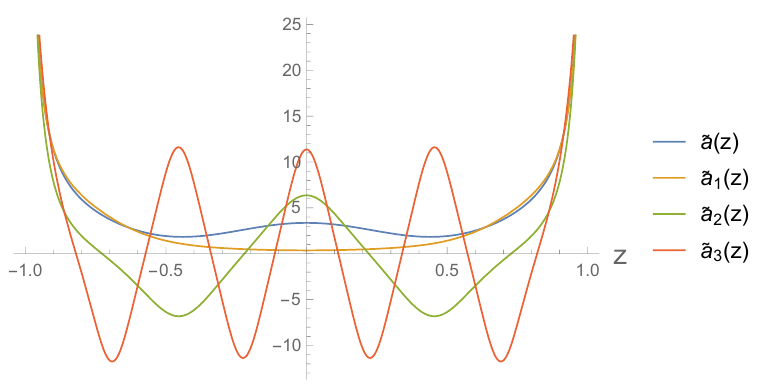
Figure 1. Multiple solutions of the ODE (3.34) with potential V ( z ) defined by the scale factor (3.38), with z 0 = 1 and mL = 3 / 2 . The solutions displayed are the original scale factor (3.38) ˜ a ( z ) , and additional solutions of the form ˜ a i ( z ) = ˜ a ( z )+ f i ( z ) , where f i ( z ) is a solution of (3.37). In particular, they are solutions of (3.37) with initial conditions f 1 (0) = − 3 , f 2 (0) = 3 , f 3 (0) = 8 . The solutions ˜ a i ( z ) are symmetric and display the asymptotic behavior (3.35). In general, there are infinite solutions of this